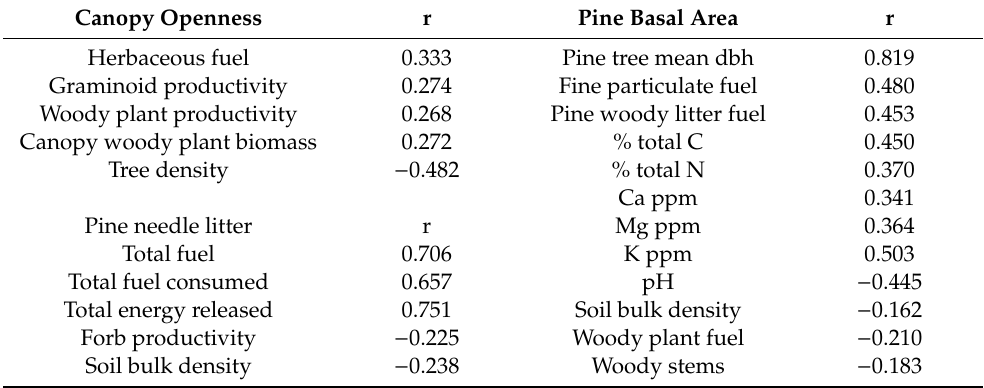
Figure 7. PCA ordination graph of the environmental characteristics in plots in each patch stage ( n = 10). Each point represents a plot ( n = 60). Soil characteristics include organic matter (OM), total nitrogen and carbon, pH, soil bulk density (SBD), and two soil moisture (SM) periods. Fire behavior attributes were of live fuel loads (herbs, woody stems) and deposited litter (woody leaves, pine needle litter, and non-needle pine litter). Measurements of plant productivity (graminoids, forbs, and woody biomass) and canopy structure (pine mean dbh and tree density) were also included. The names of the three environmental characteristics chosen for the CCA are highlighted in red: needle pine litter, canopy openness (light levels), and total basal area. Table 1. Correlations (r = Pearson’s correlation coe ffi cient) of each patch environmental variable included in the PCA with the three representative variables used in the